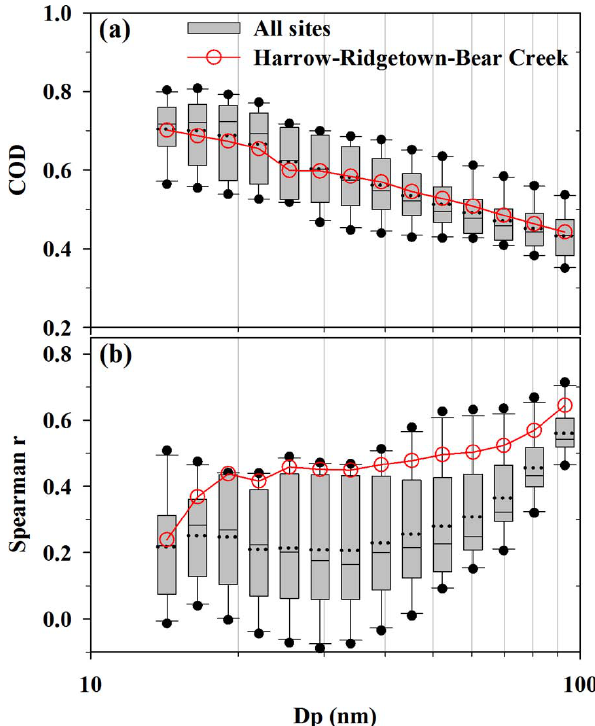
Fig. 10. Variation of CODs (a) and Spearman correlation co- efficients (b) as a function of particle size for the five (Harrow, Ridgetown, Bear Creek, Egbert, and Toronto) and three (Harrow, Ridgetown, and Bear Creek) sites during the measurement period. Box-whisker plots demonstrate the median (line), quartile (box), mean (dots), 90% percentile (whiskers), and 95% percentile